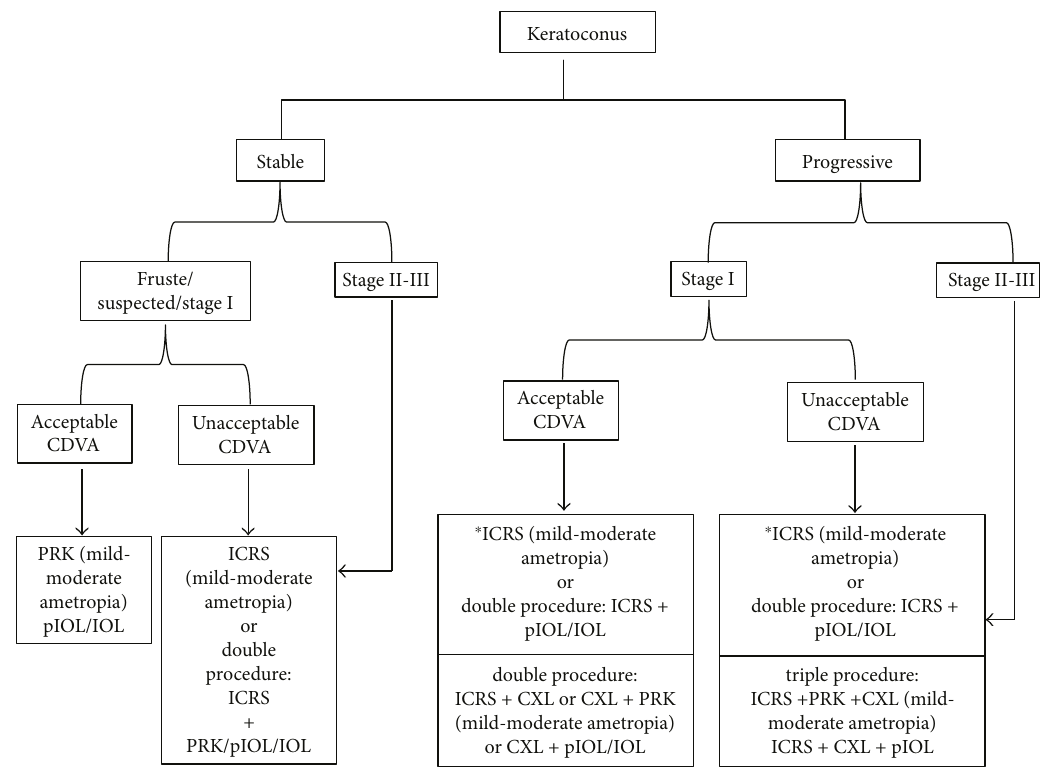
Figure 1: Decision tree treatment considering the stability or progression, the corrected distance visual acuity (CDVA), and the refractive error. PRK =photorefractive keratectomy; pIOL=phakic intraocular lens; IOL =pseudophakic intraocular lens; ICRS=intrastromal corneal ring segments; CXL =corneal collagen cross-linking. ∗ If keratoconus is stable after ICRS